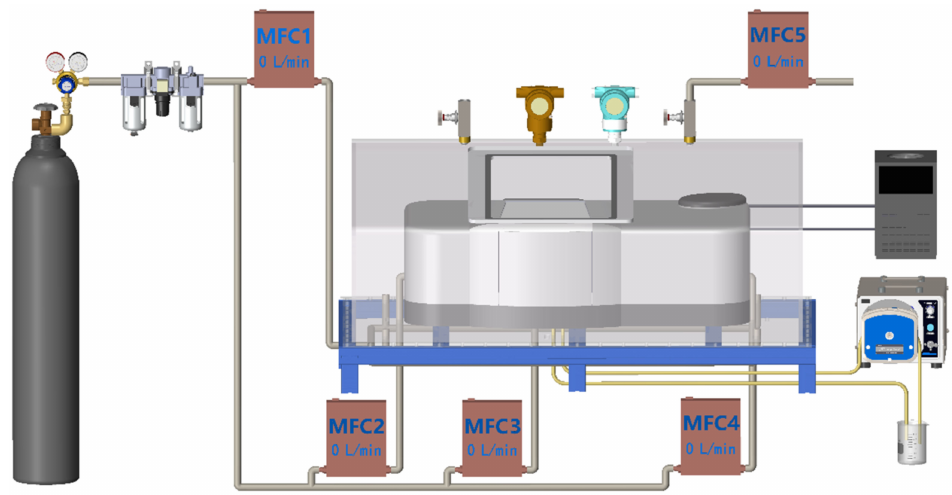
Figure 1. Manual operation diagram of the nitrogen protection device of the spectrophotometric